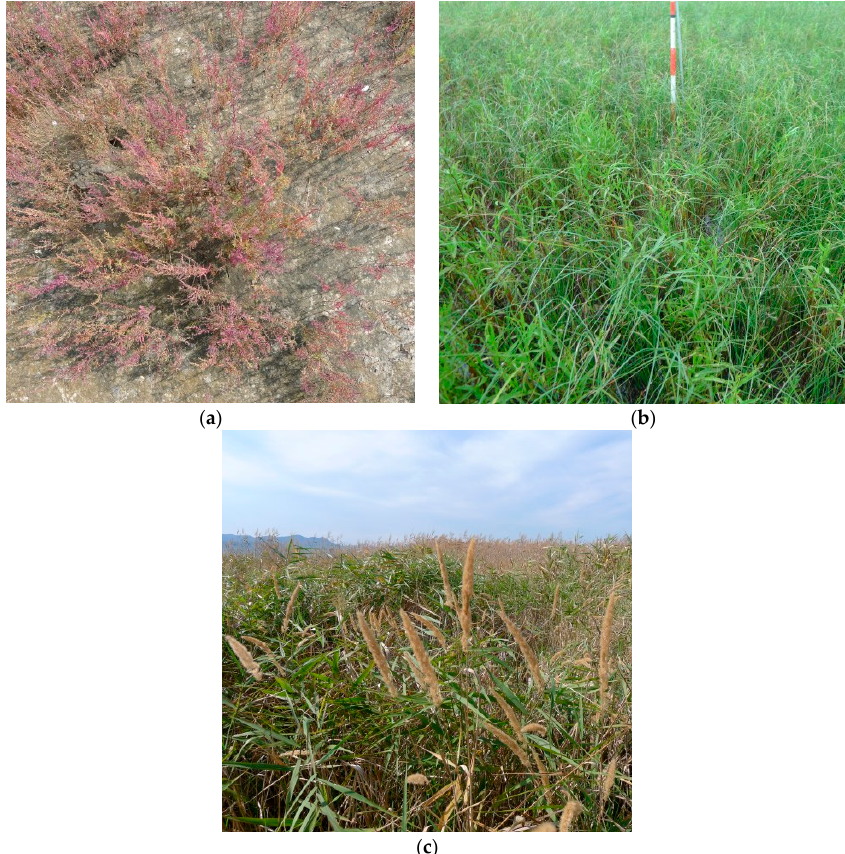
Figure 3. The typical vegetation types in Saemangeum, ( a ) HV dominated by Suaeda spp.; ( b ) MLV dominated by Aster tripolium and Carex scabrifolia ; ( c ) Reed dominated by Phragmites communis and Calamagrostis epigeios .